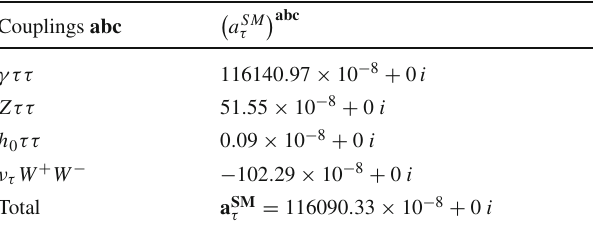
Table 11 Partial contributions to a SM τ . abc denotes the different parti- cles running in the loop of the vertex γτ + τ − Couplings abc